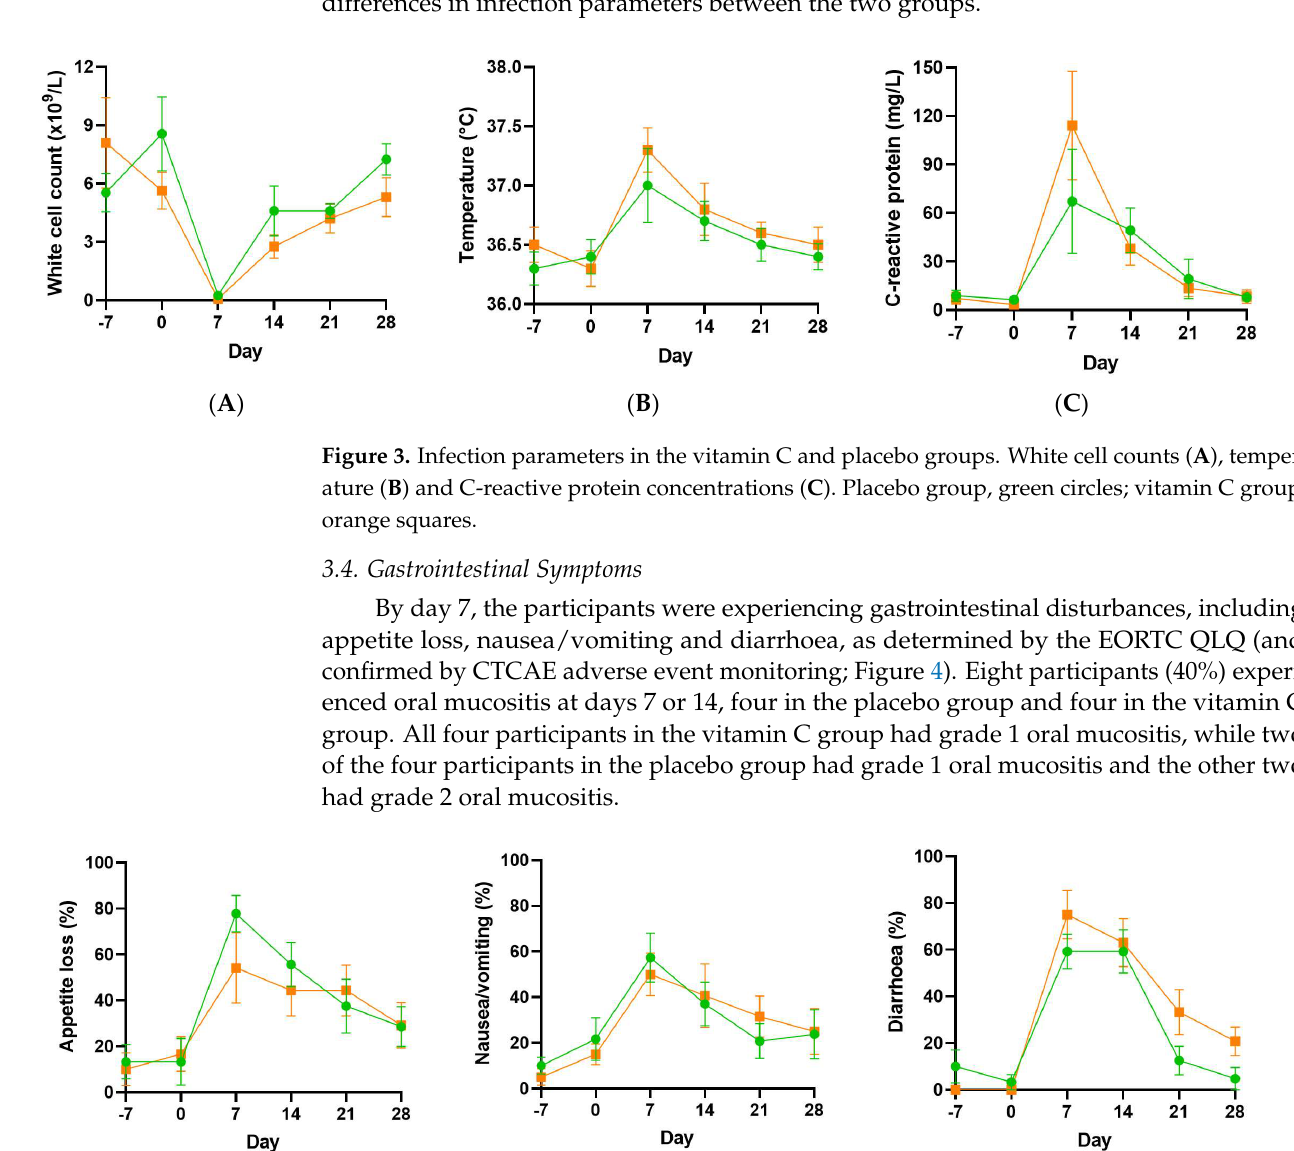
Figure 2. Effect of oral vitamin C supplementation on plasma vitamin C status of participants ( A ) and proportion with plasma vitamin C concentrations ≥ 50 µmol/L ( B ). Placebo group, green bars; vitamin C group, orange bars. Box plots represent median and 25th and 75th percentiles with min- imum and maximum whiskers. Dashed line indicates 50 µmol/L vitamin C. Mixed-effects analysis indicated a significant difference between the two groups; ** p = 0.002 by post hoc analysis.